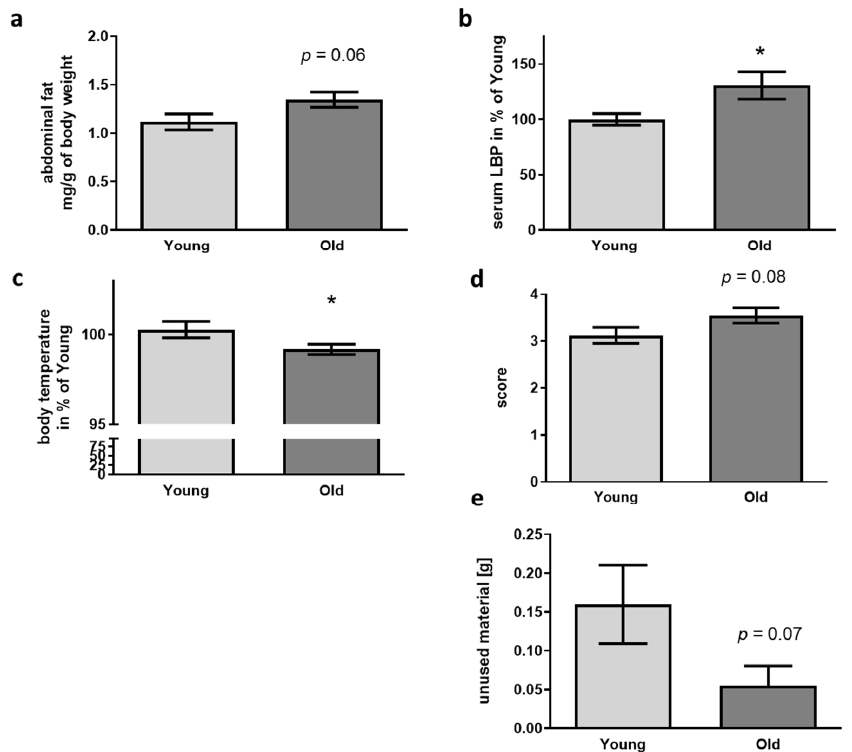
Figure 3. Physiological parameters and nest building capability in 5xFAD mice after FMT. ( a ) Abdominal fat was isolated and weighed after dissection ( n = 11 per group; “young”: 5xFAD treated with cecal material from young wt mice; “old”: 5xFAD treated with cecal material from old wt mice). ( b ) LBP was quantified from serum samples ( n = 11 per group). ( c ) Body temperature was assessed directly before sacrifice using an infrared thermometer ( n = 8 for young and 10 for old; temperature was only taken into account if the animals were not defecating or urinating during measurement procedure). ( d ) Nest quality was scored, and material not integrated in the nest weighed ( e ) ( n = 20 per group, 10 female). Data are presented as mean ± SEM (*, p < 0.05).